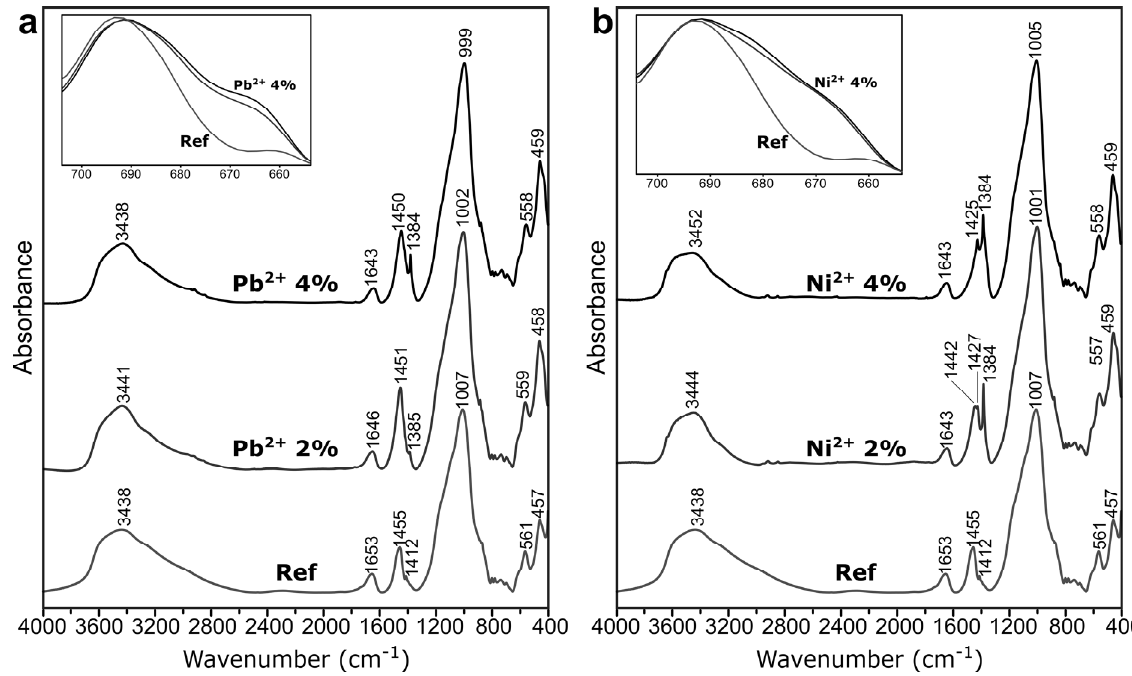
Figure 10. The FT-IR spectra of the geopolymers with heavy metals: ( a ) Pb 2+ and ( b ) Ni 2+ . Microstructure: SEM images and EDS maps of the samples with heavy metals are presented in Figure 11. There were no significant changes in the general microstructure caused by the presence of Pb (Figure 11a), though some sporadically occurring inclusions could be observed (Figure 11b). The elemental mapping of the general structure of the sample with lead showed that Si, Al, O, Na, and Pb were distributed regularly throughout the sample, which indicates the bonding of lead cations to the geopolymeric network